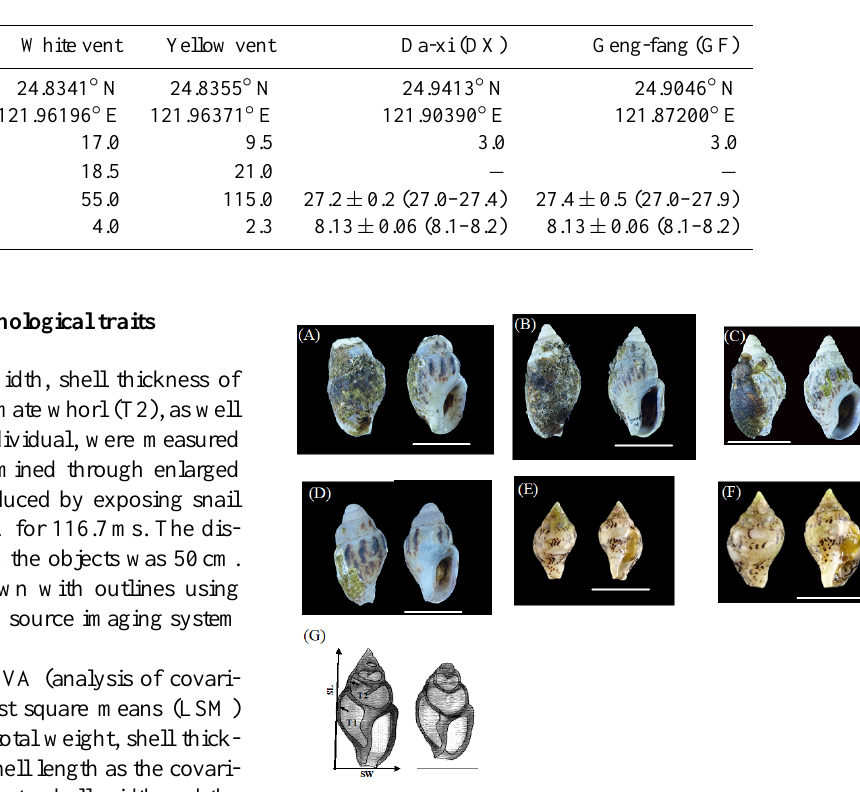
Table 1. Sampling locations and environmental parameters of vent sites in the Kueishan Islet and northeastern Taiwan. Data are shown as mean ± SD (range of parameter).